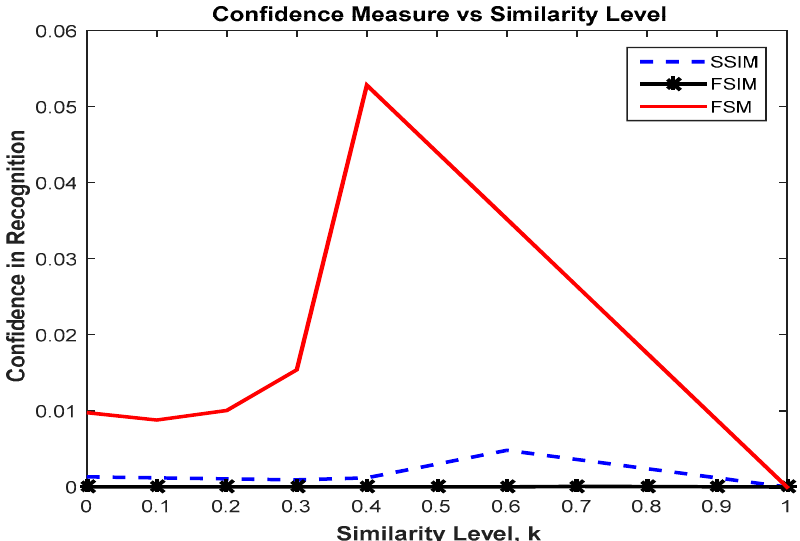
Figure 14. Recognition confidence for similarity measures SSIM, FSIM and FSM using person No. 5 (pose 7) in FEI database.